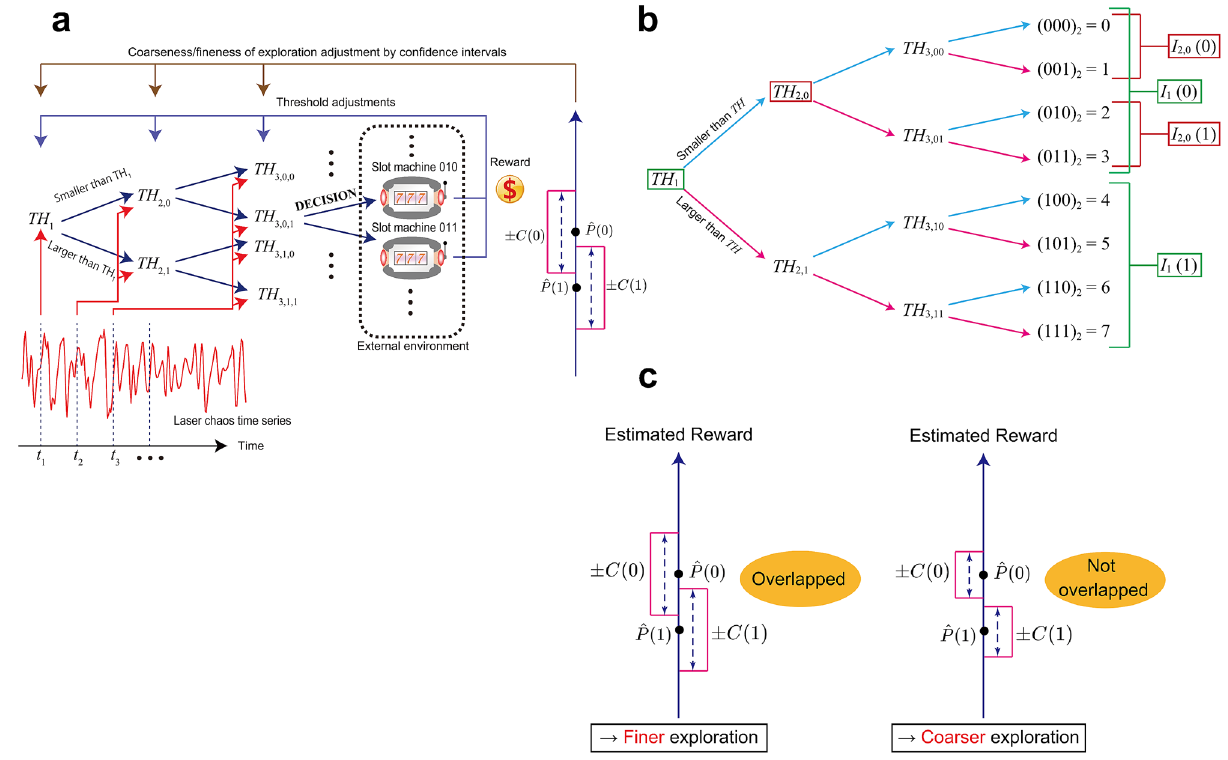
2 M = ) in the example of an 0, 1 ∈ { } ( 0 ) and I ( 1 ) are defined. ( c ) ∗ ∗ , the fineness of ∗ n ) C n ) and ( 0 ( 0 ; ± ; ∗ ∗